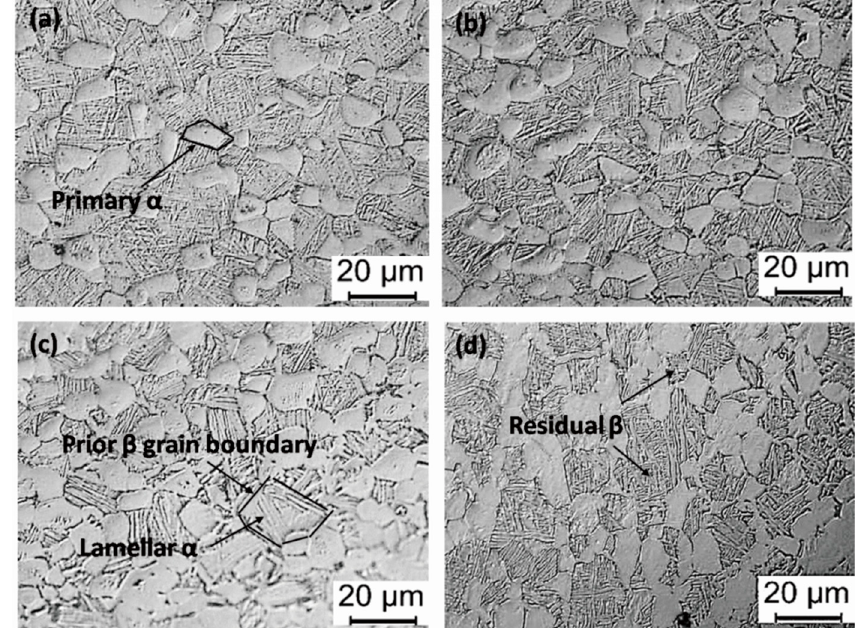
Figure 9. Microstructure under the different solution treatments followed by aging. ( a ) 960 °C × 1 h, AC + 600 °C × 2 h, AC; ( b ) 960 °C × 1 h, AC + 650 °C × 2 h, AC; ( c ) 960 °C × 1 h, AC + 700 °C × 2 h, AC; and ( d ) 960 °C × 1 h, AC + 750 °C × 2 h, AC.